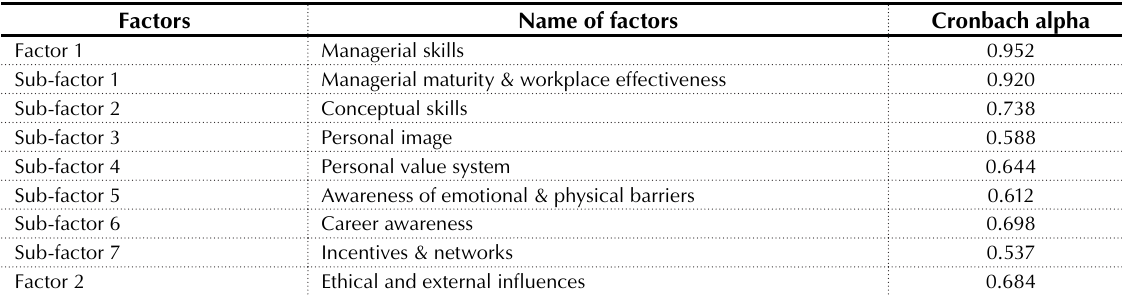
Table 8. Names and the reliability coefficients of the factors